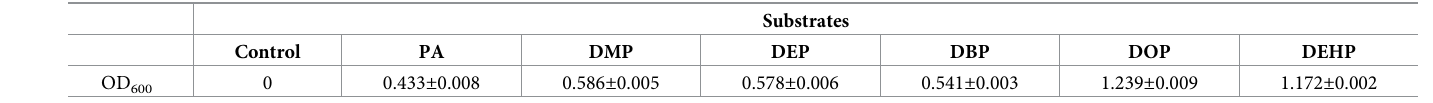
Table 2. Growth profile of LF on various of aromatic